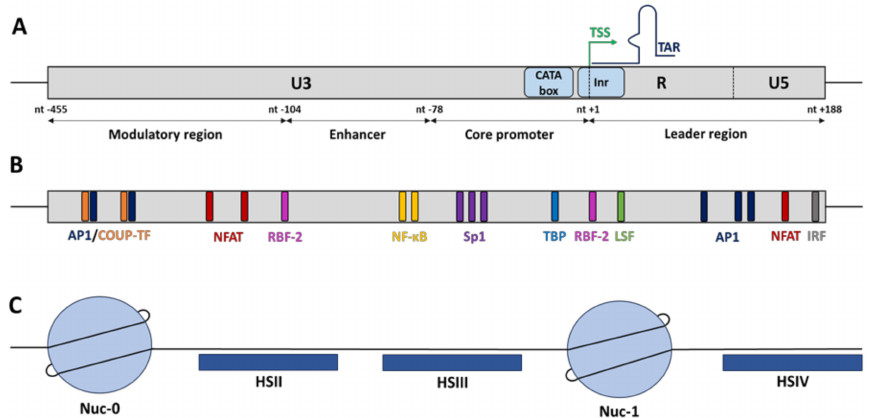
Figure 1. Schematic representation of the HIV-1 5 (cid:48) -long terminal repeat (5 (cid:48) LTR) promoter. ( A ) The 5 (cid:48) LTR can be divided into four functional domains: the modulatory region (from nt − 455 to nt − 104), the enhancer (from nt − 109 to nt − 79), the core promoter (from nt − 78 to nt − 1), and the leader region (from nt + 1 to nt + 188). ( B ) These functional domains contain numerous cis -regulatory elements specific to various host cellular factors. The transcriptional start site (TSS) is located at the junction between the U3 and R regions. ( C ) The HIV-1 5 (cid:48) LTR harbours a specific nucleosomal chromatin organization. Under latency conditions, two major DNaseI hypersensitive sites (HS), named HSII (from nt − 234 to nt − 132) and HSIII (from nt − 67 to nt − 7), are framed by two nucleosomes, nuc-0 and nuc-1. The nucleosome nuc-1 is located